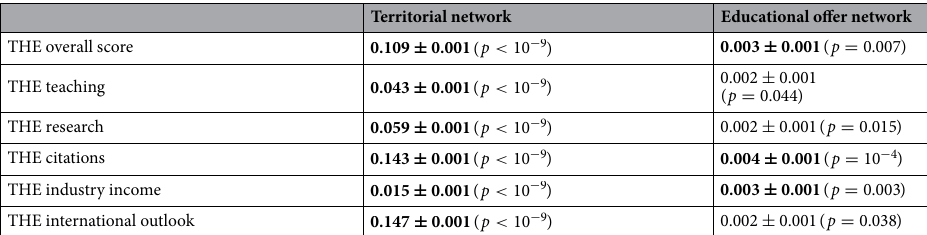
Table 1. Assortativity of the territorial network and the educational offer network of the OECD case study with respect to the following THE rankings: overall , teaching , research , citations , industry income , international outlook . For each assortativity value, the standard error and p -value, computed according to the Student t -distribution hypothesis, are provided (see “Materials and methods” section for details); significant 2 assortativity values ( p < 10 − ) are highlighted in